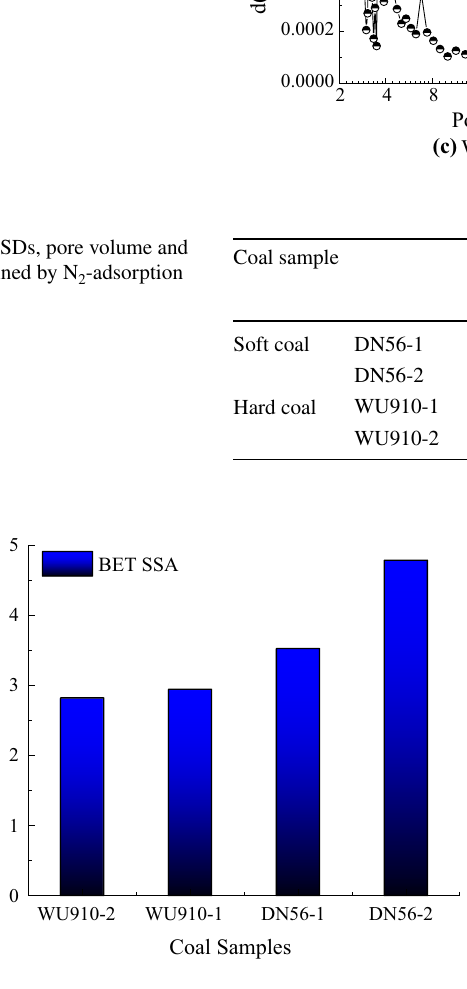
Fig. 4 BET-SSA comparison with samples from Ding5-6 and Wu9- 10 coal